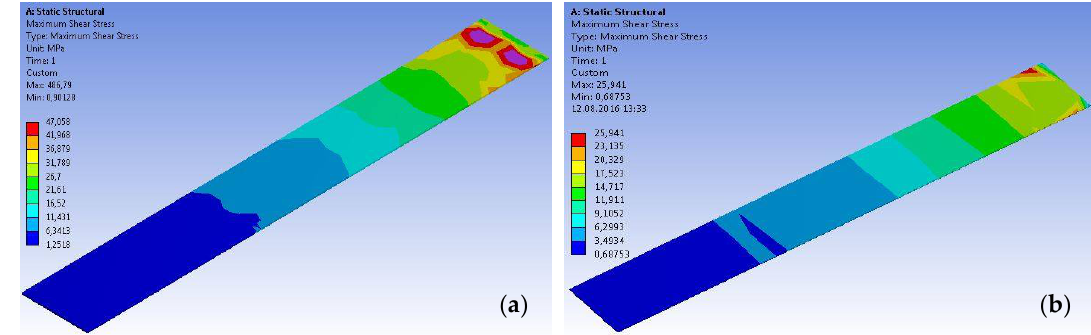
Figure 21. Typical shear stress distribution maps at the level of the adhesive layer: ( a ) S-S512-30-1 and ( b ) S-M514-30-1 types (only the adhesive layer is presented).